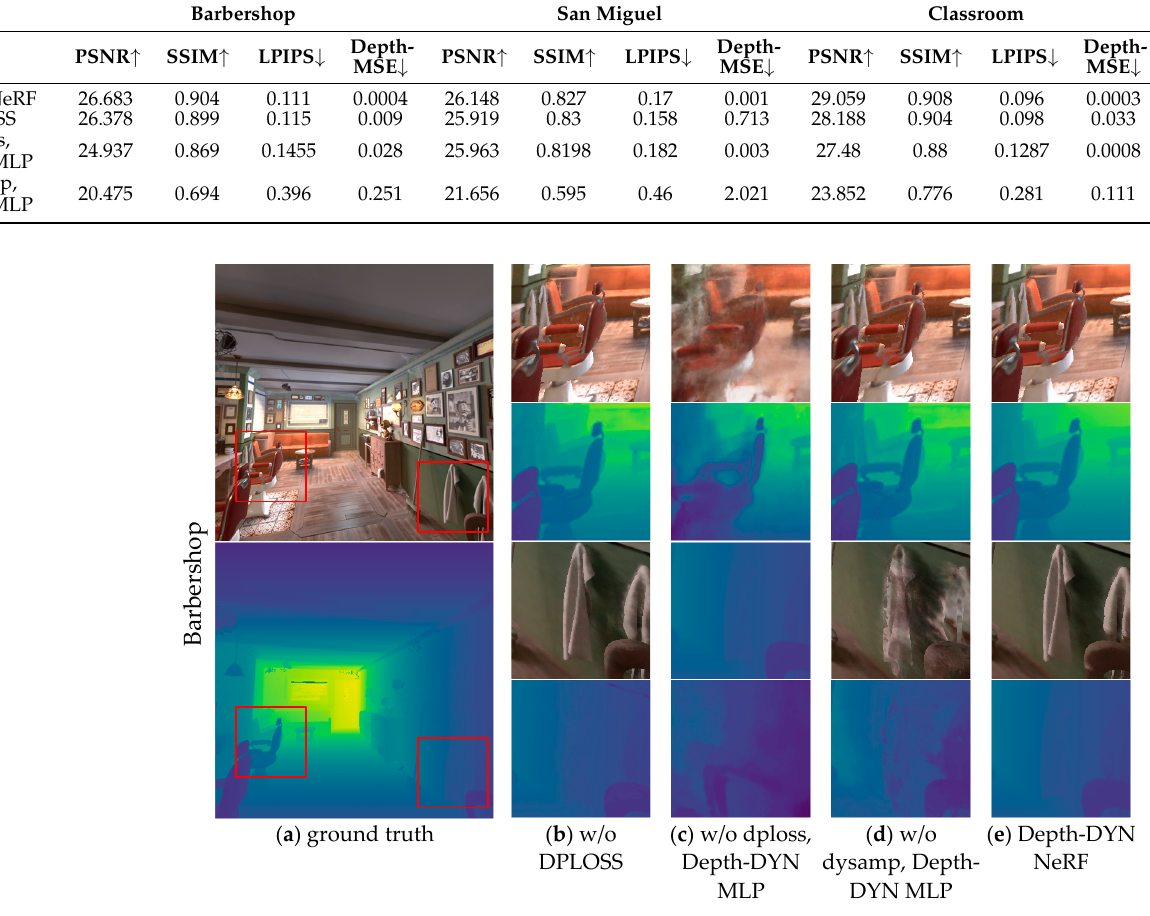
Figure 9. Rendered image and depth of the test scene vs. real image and depth.